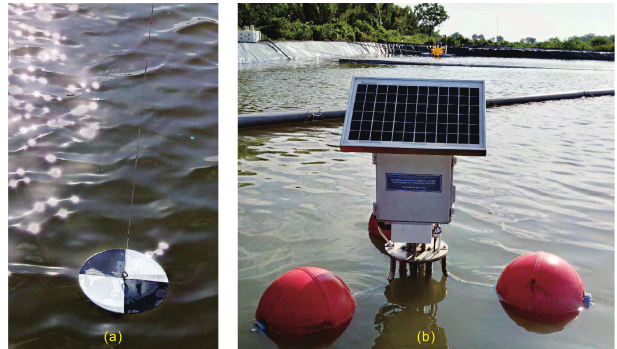
Figure 1. Measurement in field condition: ( a ) manual measurement by using Secchi disk; and ( b ) automatic measurement by using our proposed